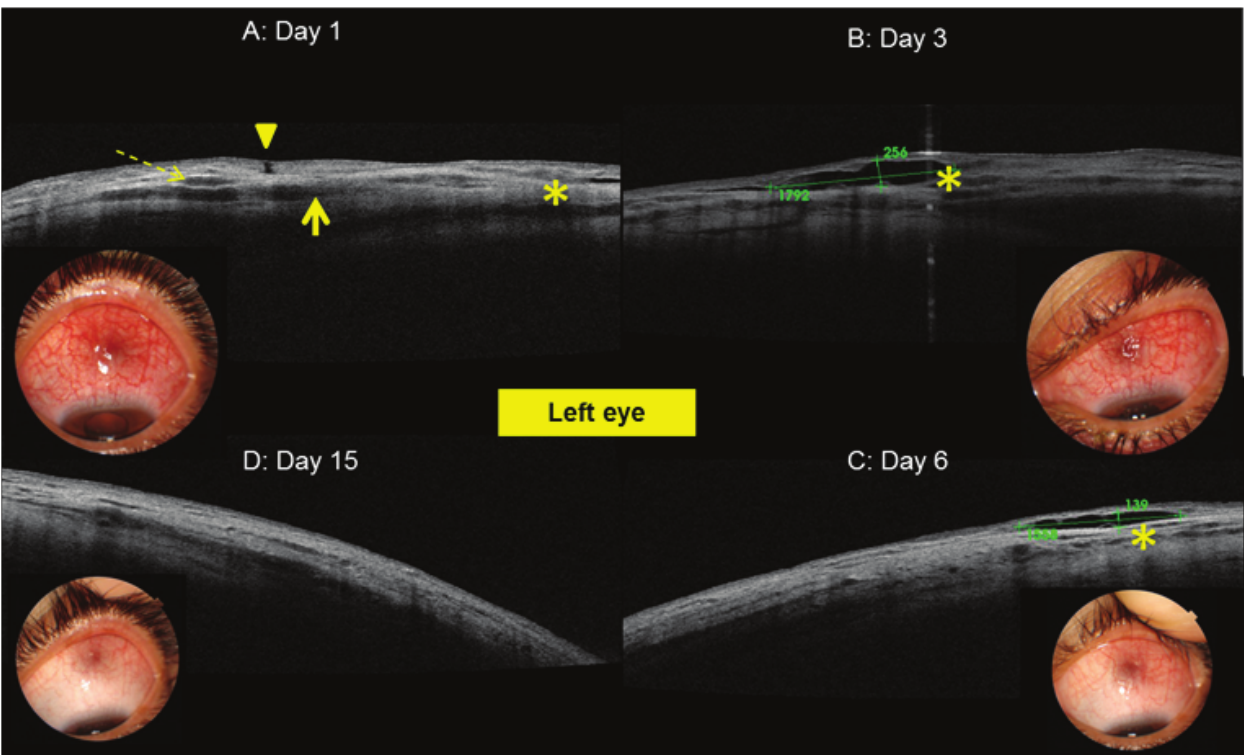
Figure 1. (A) Optical coherence tomography images of the left eye showed separated fibers (dashed arrow), enlarged vessels, inflammatory infiltrates (solid arrow), serous detachment between them (asterisk), and the site of conjunctival biopsy (arrow head). (B, C, D) Evolution after penicillin treatment.